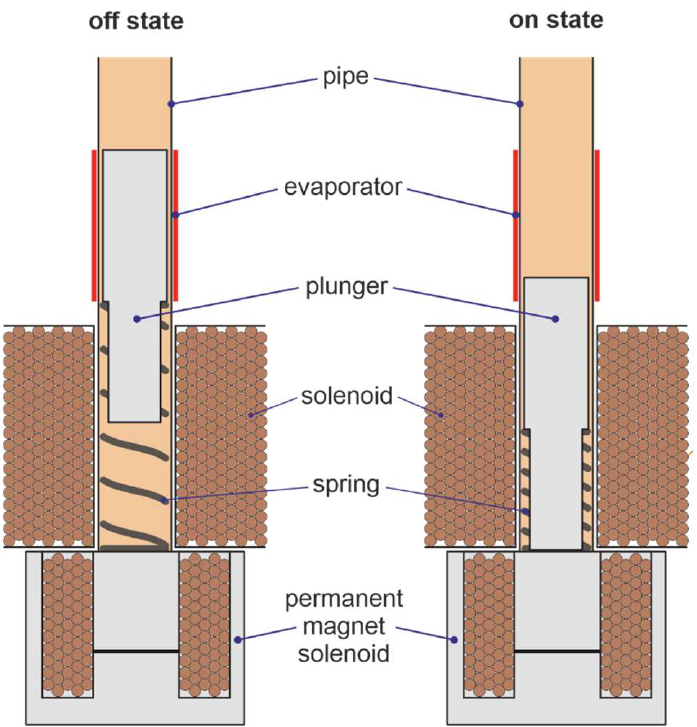
Figure 1. Cross section of the thermosiphon design with thermal switch.